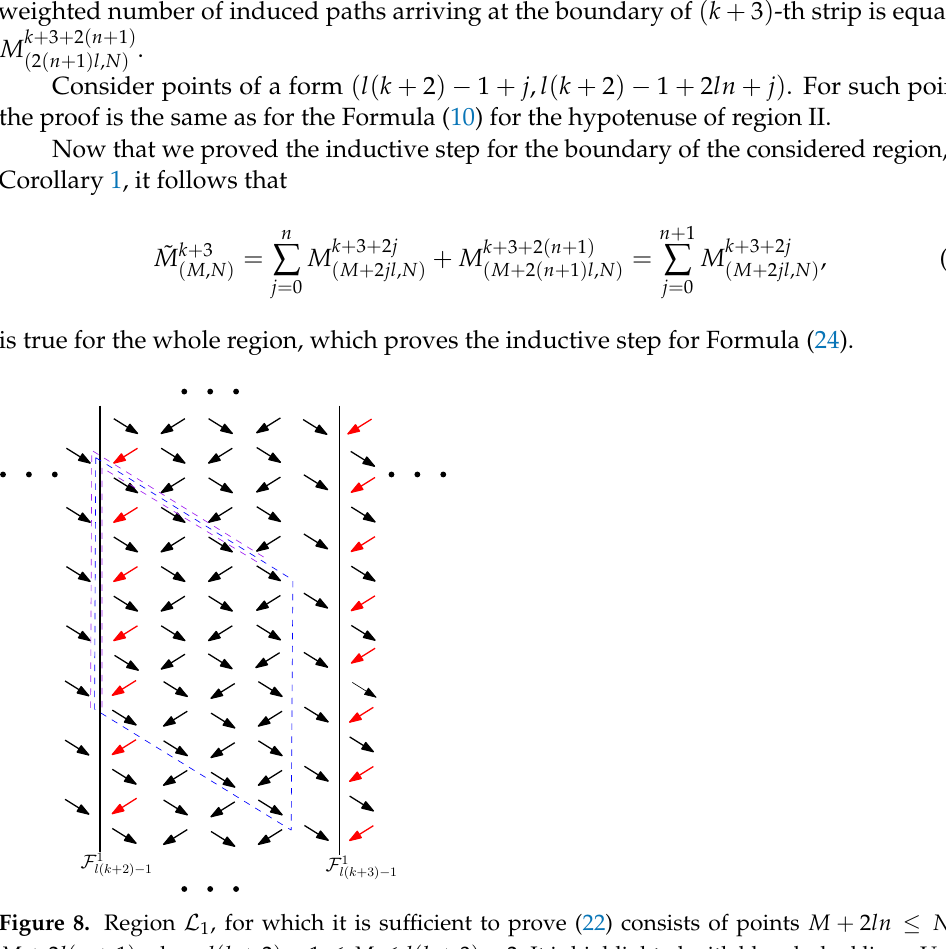
( ∂ L ) ∪ T − 1 ( ∂ L ) consists of 2 3 2 1